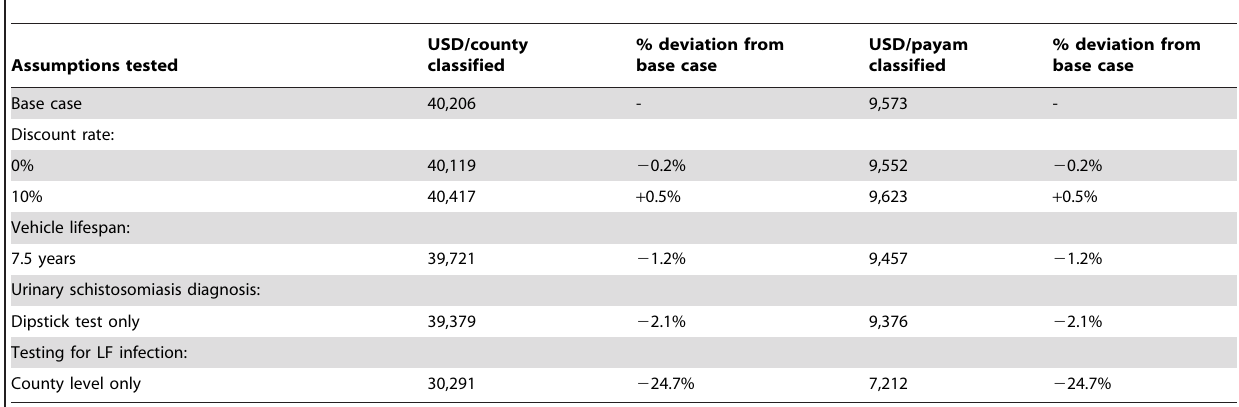
Table 3. Sensitivity of cost estimates to underlying assumptions or modification of routine operating procedures.